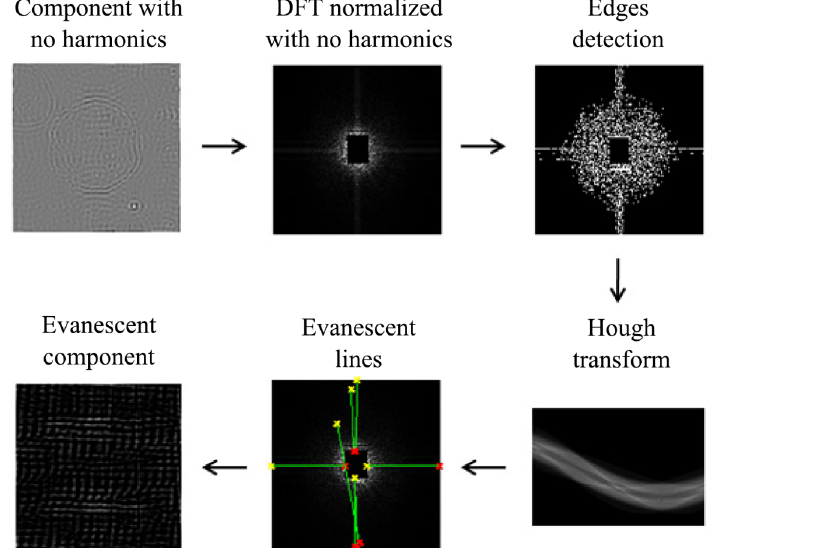
Fig 6. Generalized evanescent field